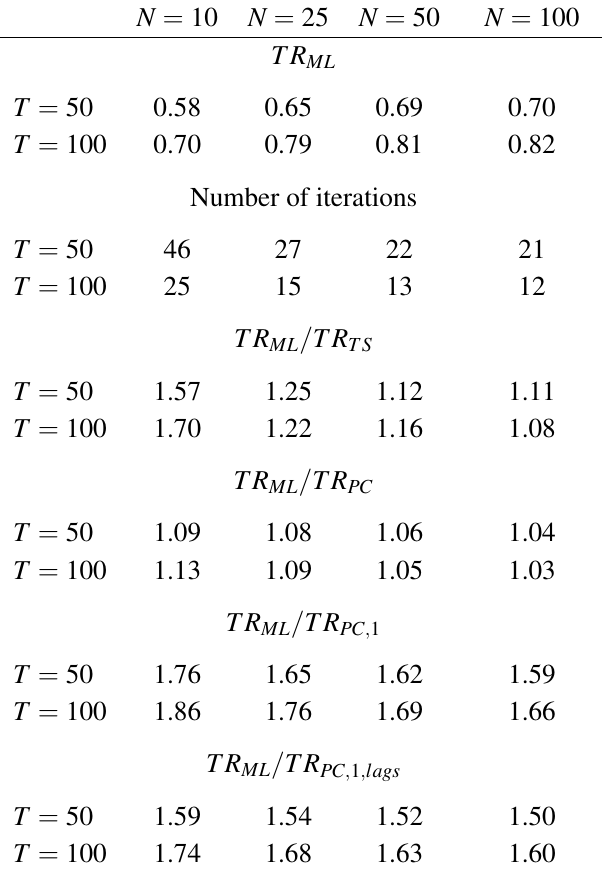
Table 7: Extended